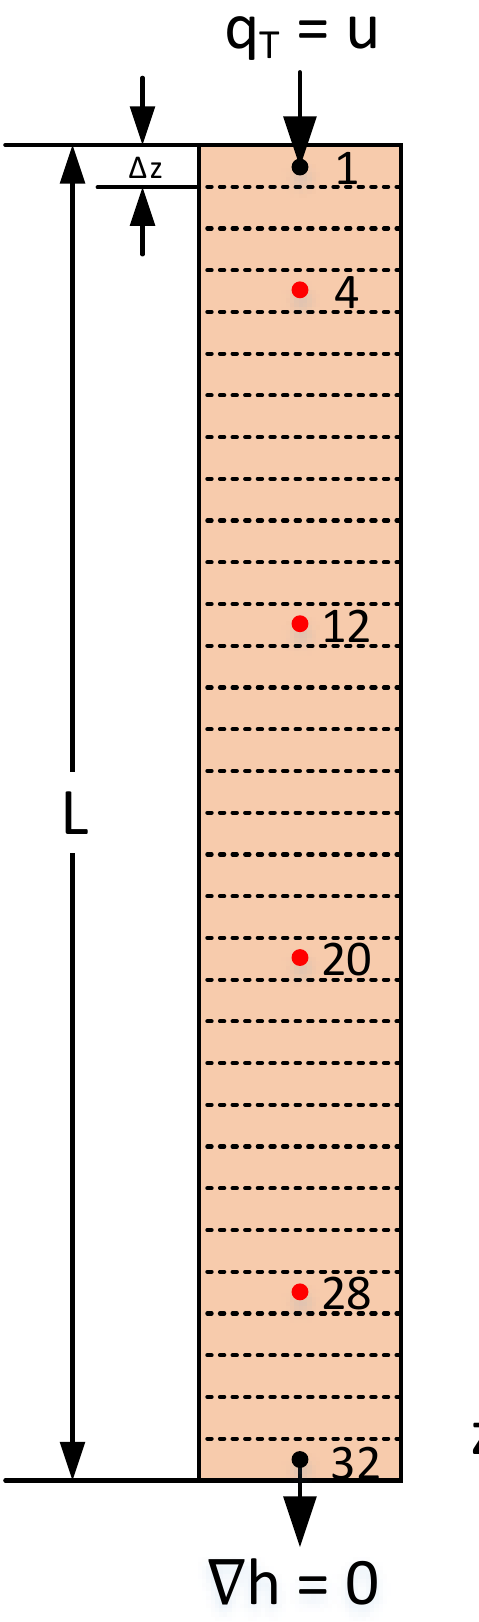
Figure 3. A schematic diagram of the investigated loam soil